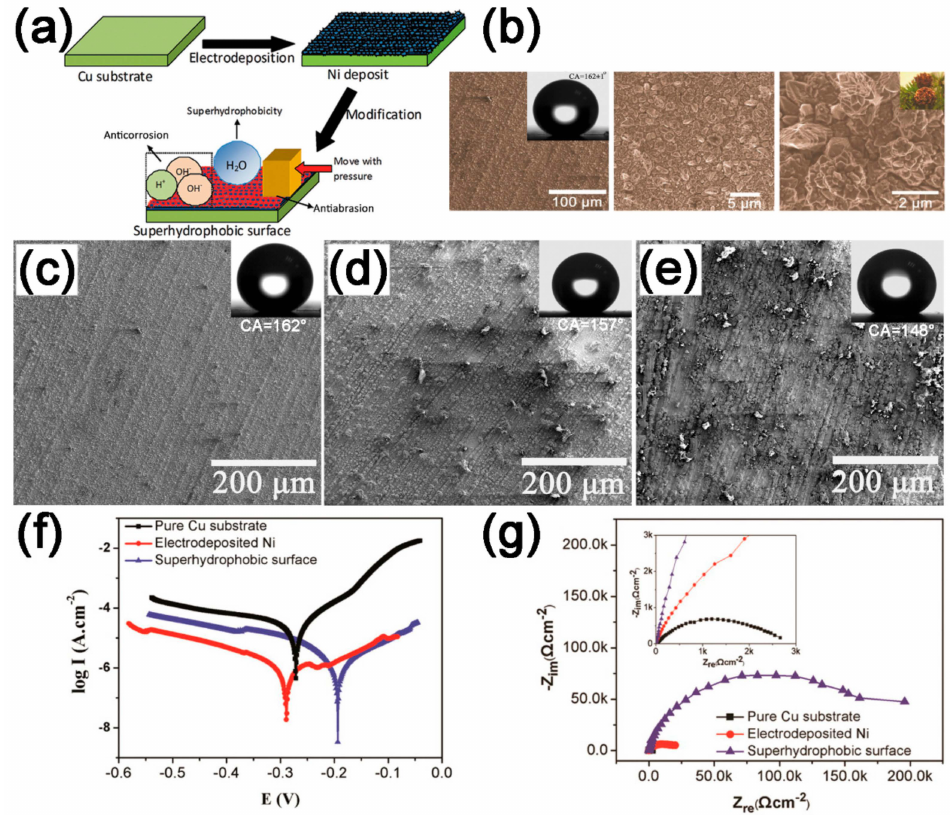
Figure 14. ( a ) Schematic of the electrochemical deposition process; ( b ) SEM images and contact angle of super-hydrophobic Ni (Ni-III) surface; ( c – e ) SEM images and contact angle of the super-hydrophobic surface (c) before and after abrasion for 1.0 m at applied pressure of ( d ) 2.4 kPa and ( e ) 6.0 kPa; ( f , g ) Potentiodynamic polarization curves and Nyquist plots of Cu substrate, electrodeposited Ni and the super-hydrophobic surface in 3.5 wt % NaCl solution. Reprinted with permission from [60]. Copyright (2014) American Chemical